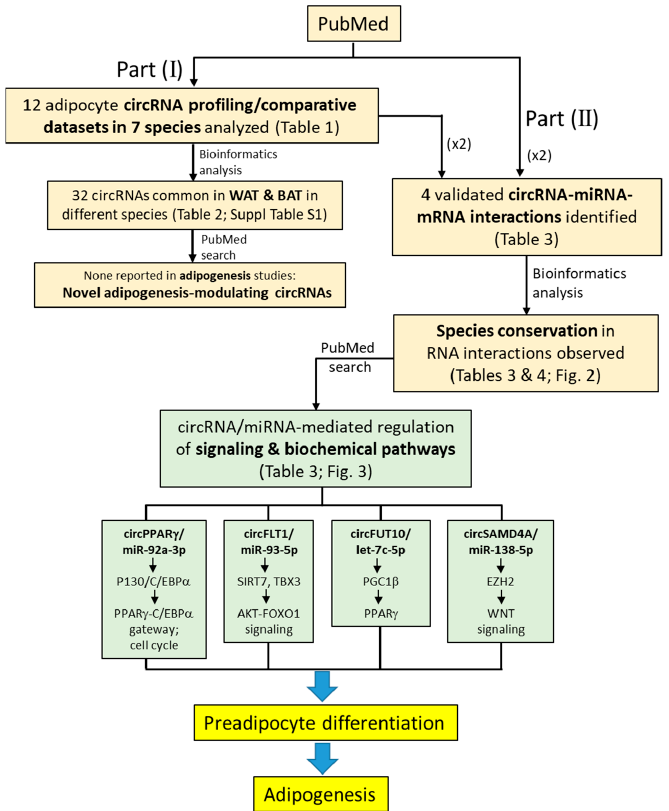
Figure 4. Pathway of analysis in the identification of circRNAs, miRNAs, proteins and modulated pathways leading preadipocyte differentiation in adipogenesis. Part (I): Identification of circRNAs using 12 datasets derived in circRNA profiling and comparative studies in different species. Twenty-three circRNAs common to two or more WATs and BATs in different species are identified, none of which has not been reported in adipogenesis studies. Part (II): Identification of selected circRNAs, which are validated in circRNA–miRNA–mRNA interactions, and which show species conservation in the RNA interacting sequences. The circRNA/miRNA-mediated signaling and biochemical pathways leading to adipogenesis differentiation are also analyzed. See text for